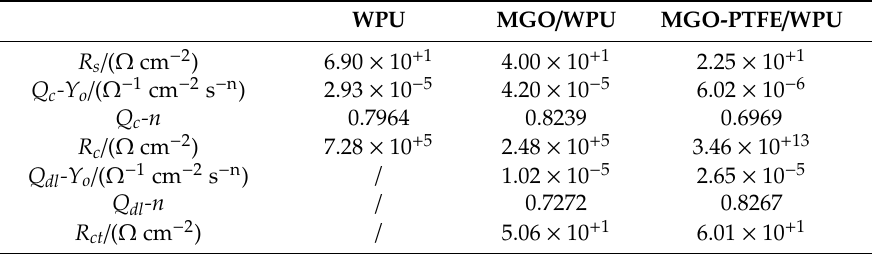
Table 2. Fitting data of pure WPU coating, 0.5 wt.% MGO/WPU composite coating and 0.5 wt.% MGO-PTFE/WPU composite coating.